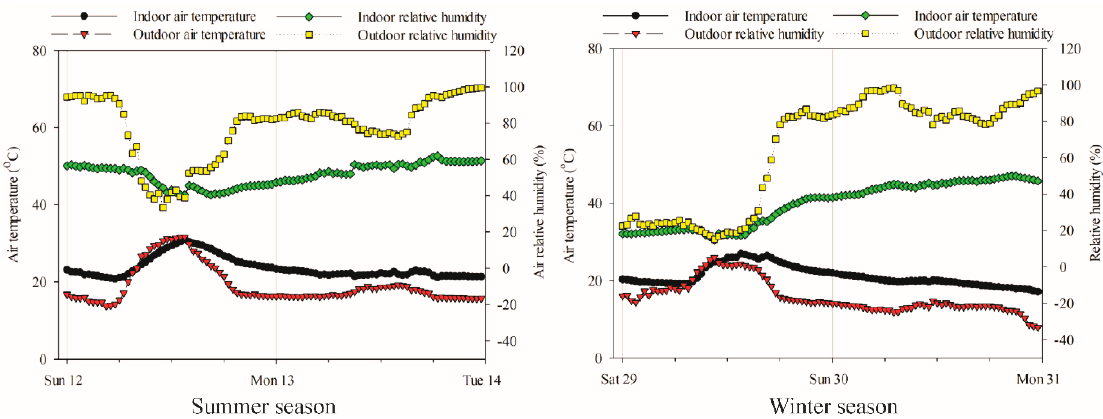
Figure 9. Seasonal air temperature and relative humidity response of the passive solar building on a typical clear sky and overcast day.